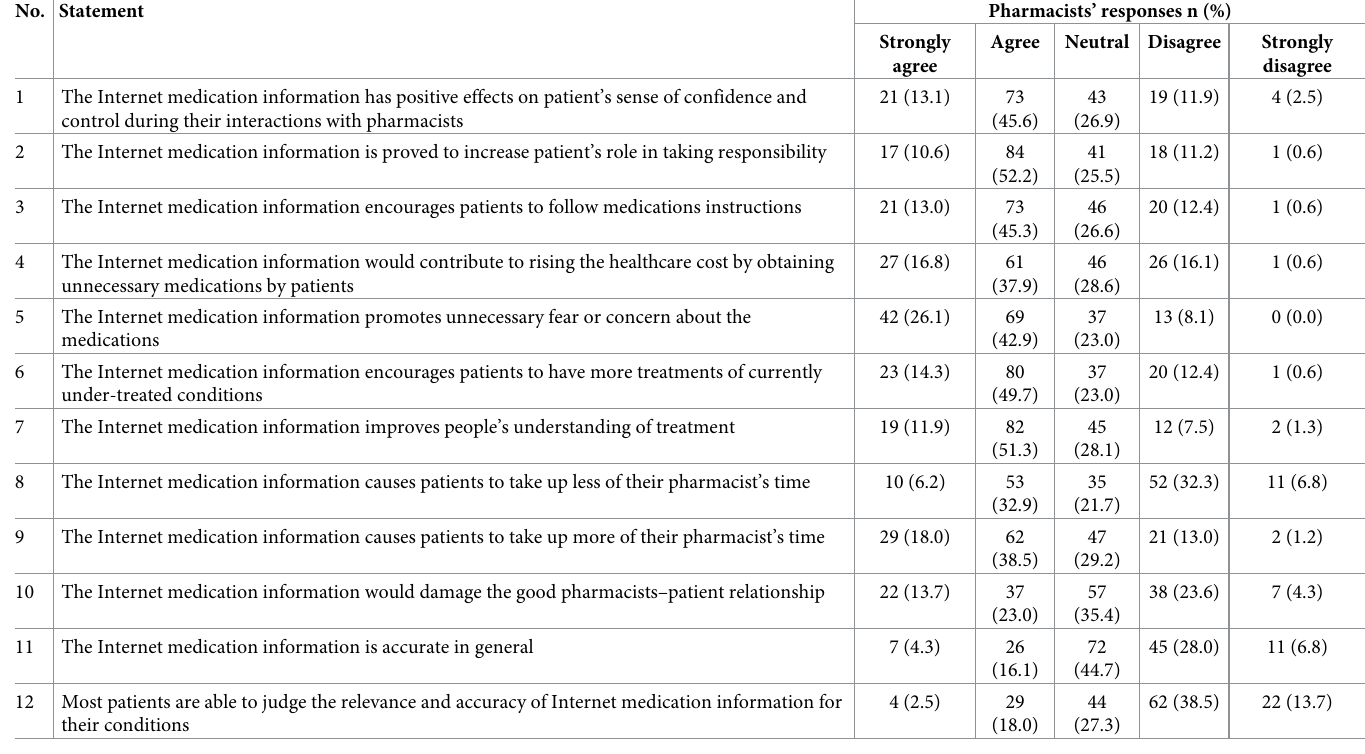
Table 2. Pharmacists perceived attitude to patient use of Internet-based medication